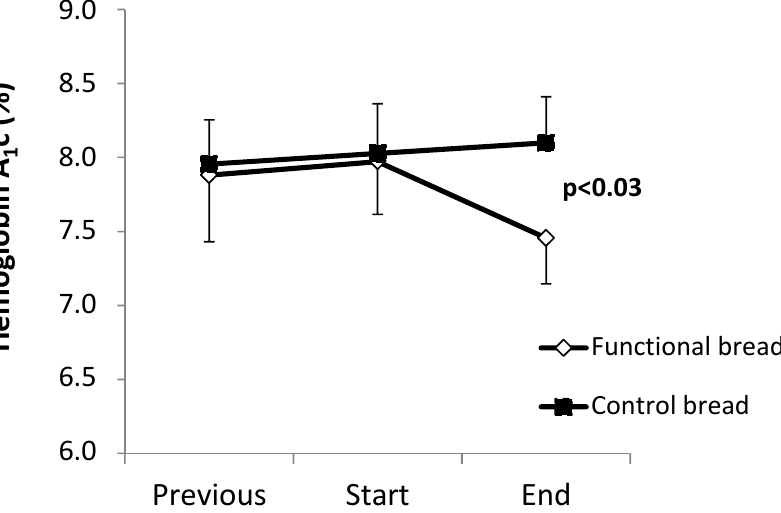
6.6 ± 0.6 months; control group: 7.7 ± 1.0 months, p = 0.34 between the two).